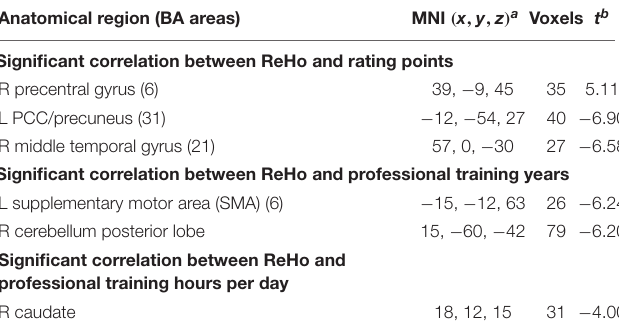
TABLE 2 | Significant correlations between ReHo and training profiles in PCCPs. Anatomical region (BA